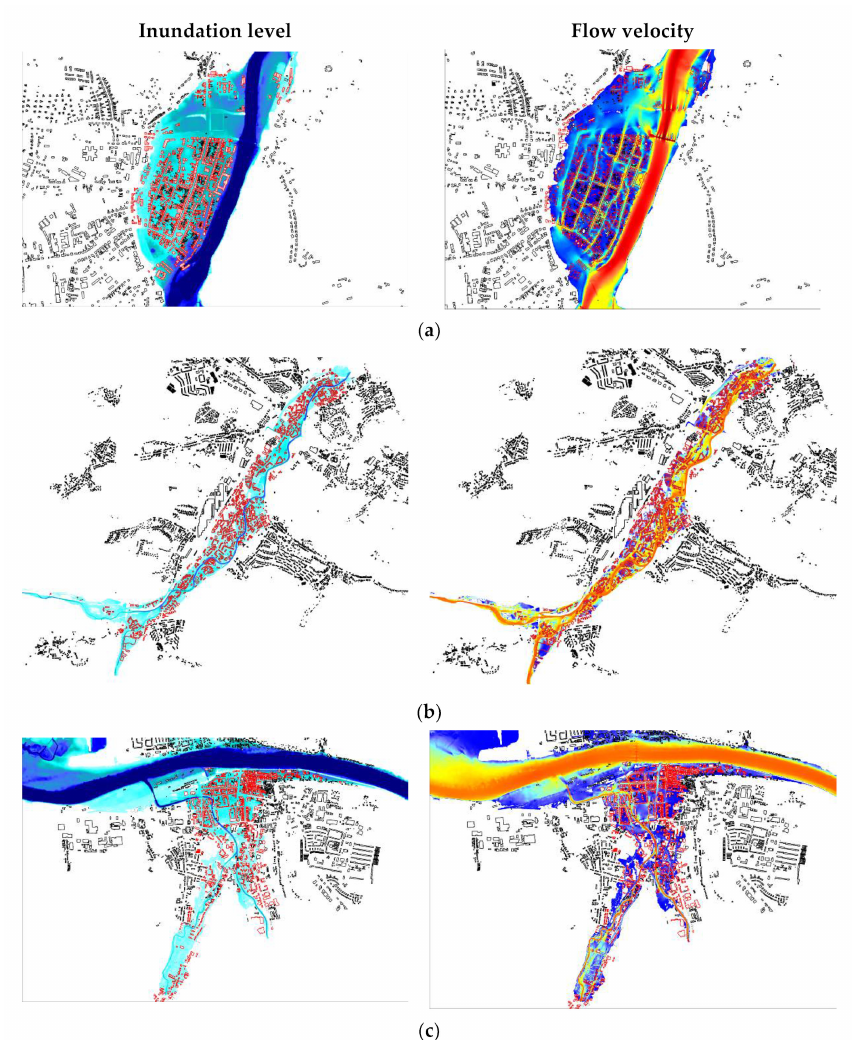
Figure 4. Inundation levels and flow velocities in the investigation areas: ( a ) Grimma; ( b ) Freital; ( c )